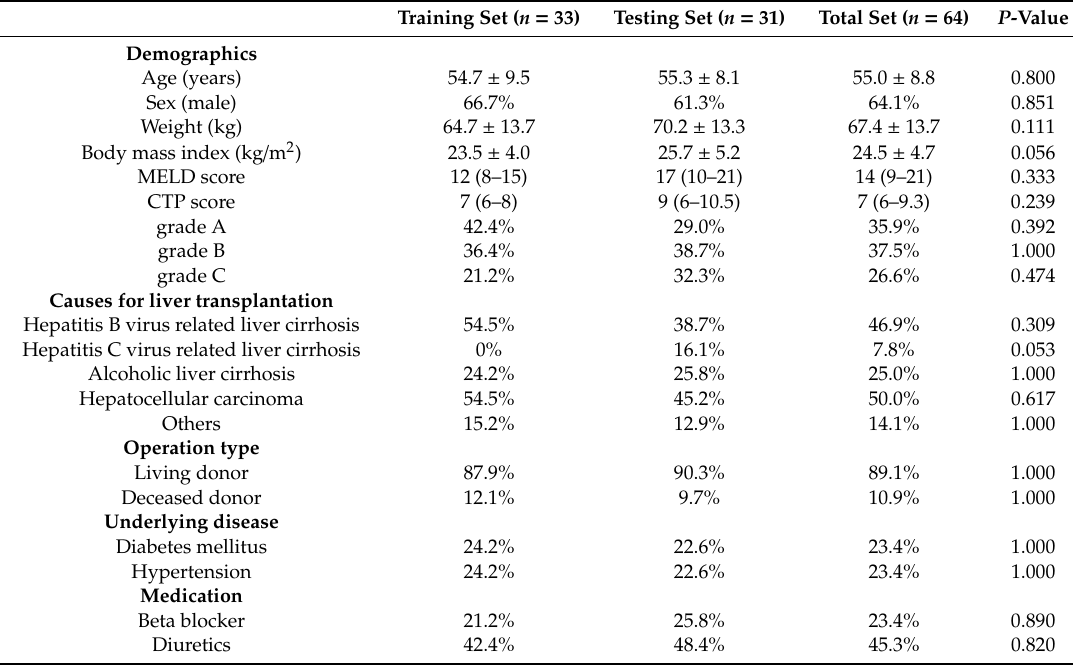
Table 1. Patient characteristics for training and testing